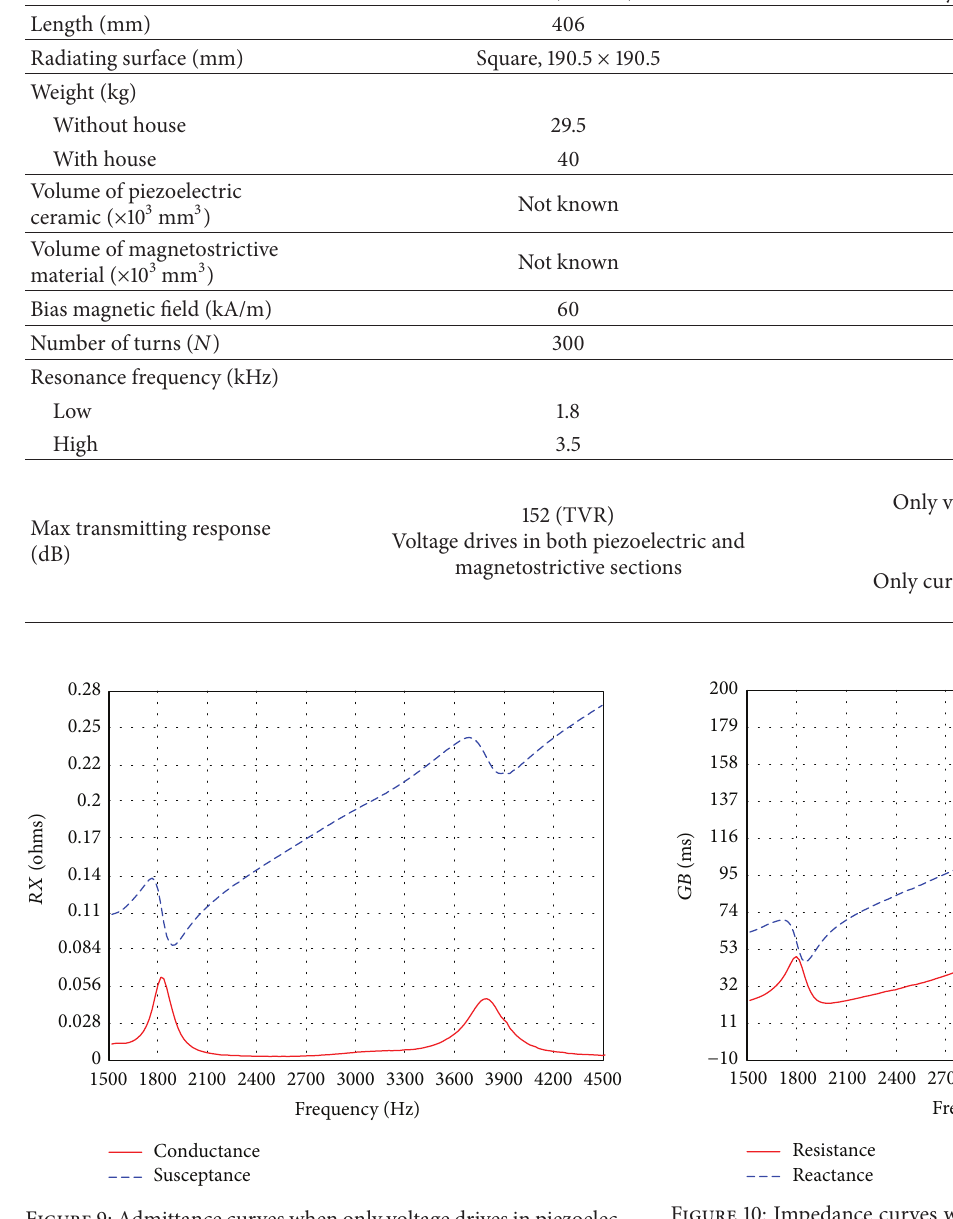
Figure 9: Admittance curves when only voltage drives in piezoelec- tric section (in water, obtained from Agilent 4294A).